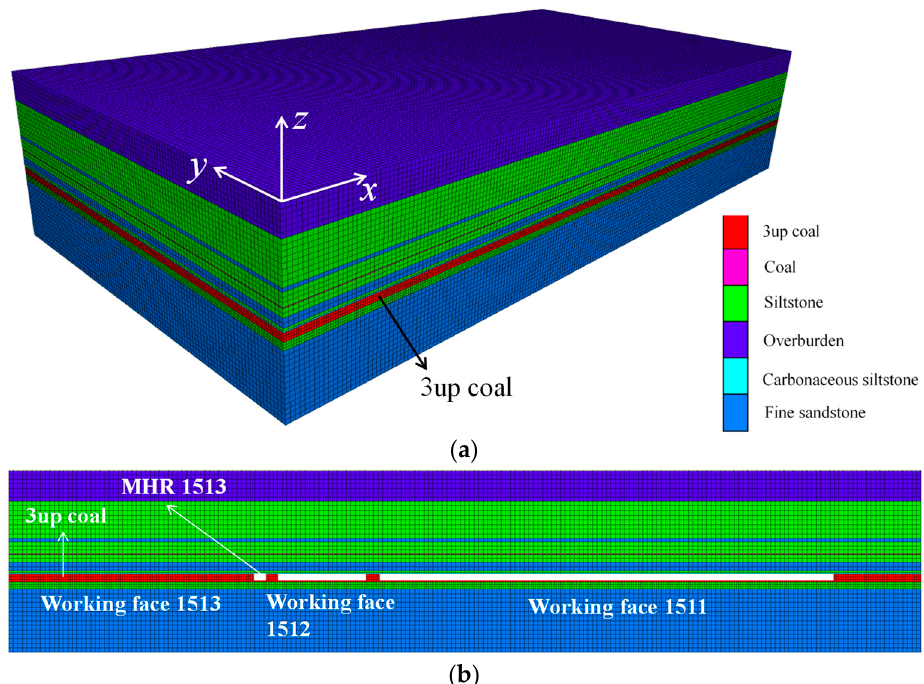
Figure 3. Numerical calculation model: ( a ) 3D model; ( b ) schematic d iagram of plane model.